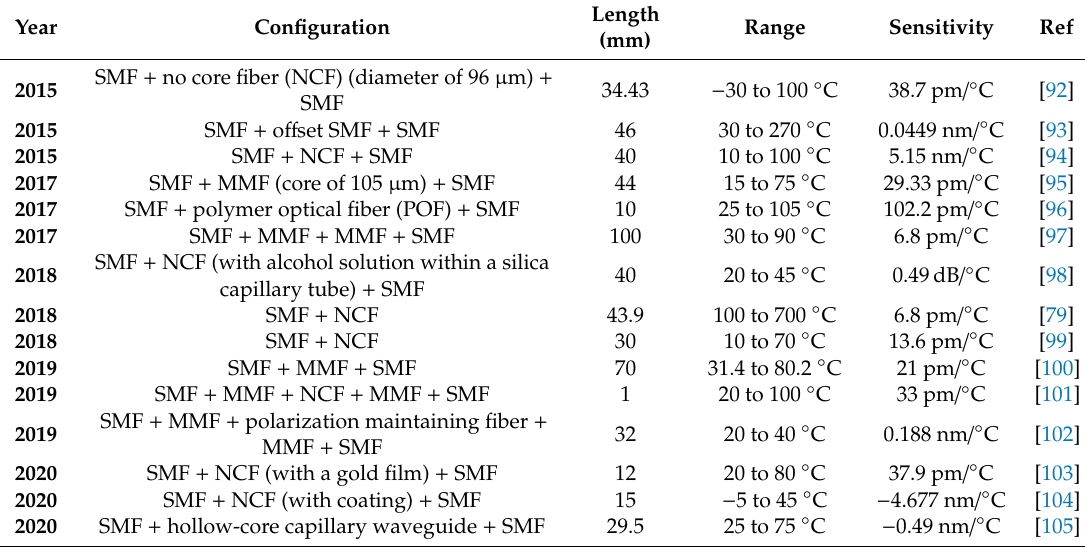
Table 2. Multimode interference sensors reported in the literature from 2015 to